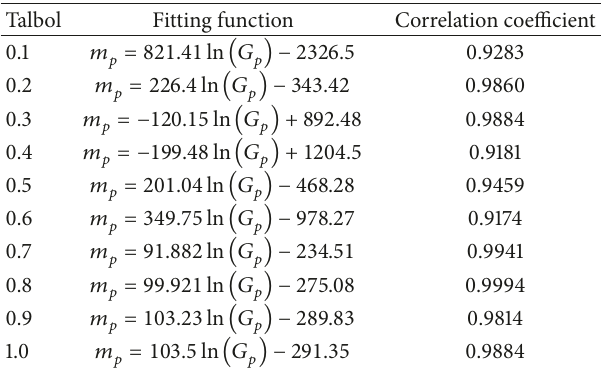
Table 4: Functional relationship of mass loss with pressure gradient and their correlation